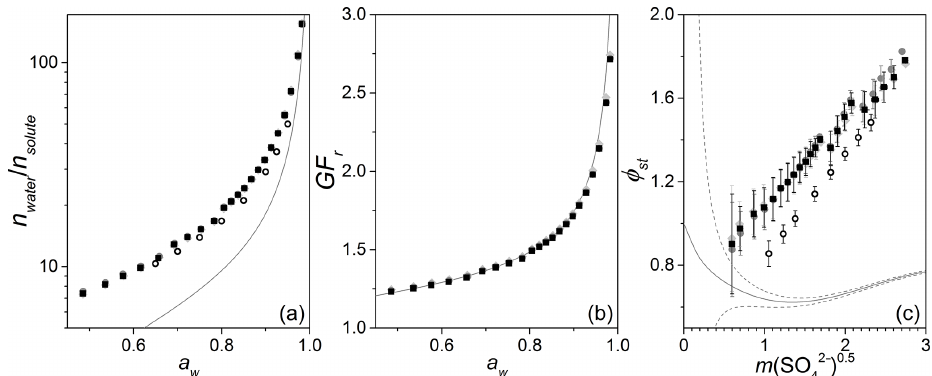
Figure 10. Hygroscopic properties of DMAS obtained from the treatment of the CK-EDB kinetics evaporation data with the three different set of parameters in Table 1 for treating solution density. Symbols: black squares – original data; dark grey dots – obtained with “Error + ” parameters; light grey diamonds – obtained with “Error − ” parameters; open circles – Sauerwein et al. (2015); solid lines – E-AIM model for (NH 4 ) 2 SO 4 ; dashed lines – uncertainty on (NH 4 ) 2 SO 4 osmotic coefficients corresponding to an error in a w of ±